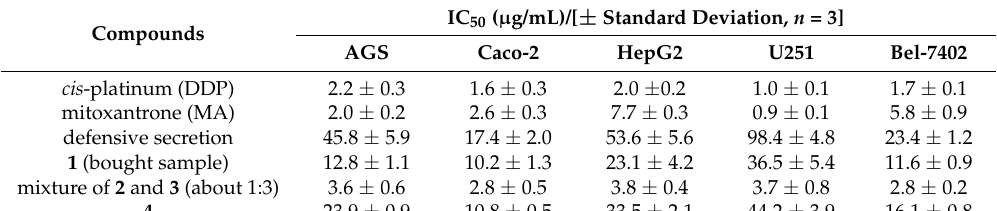
Table 1. IC 50 inhibition of TDS and its main constituents against human cancer cell lines.